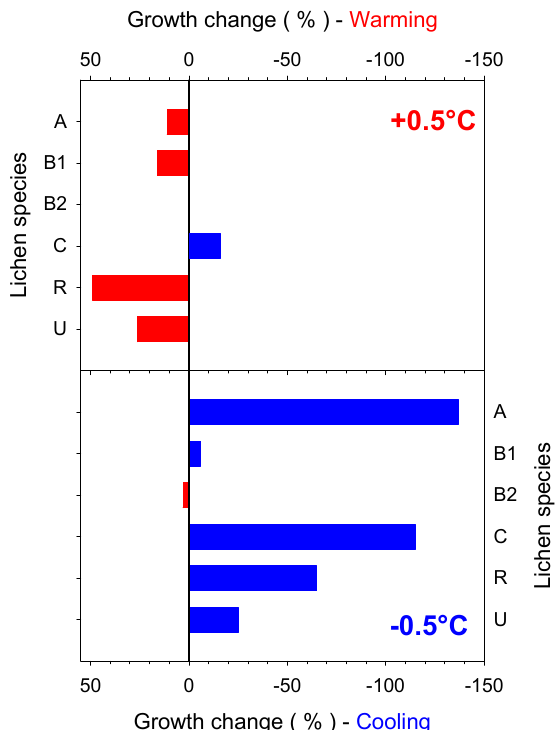
Figure 5. Changes in thallus growth rate observed for six lichen species on Livingston Island. Upper panel—warming of 0.5 °C, lower panel—cooling of 0.5 °C; bar colour: Red, increased growth rate, blue, decreased growth rate. Species: A— Acarospora macrocyclos ; B1— Bellmerea sp.; B2 —Buellia latemarginata ; C —Caloplaca sublobulata ; R —Rhizocarpon geographicum ; U— Usnea antarctica .